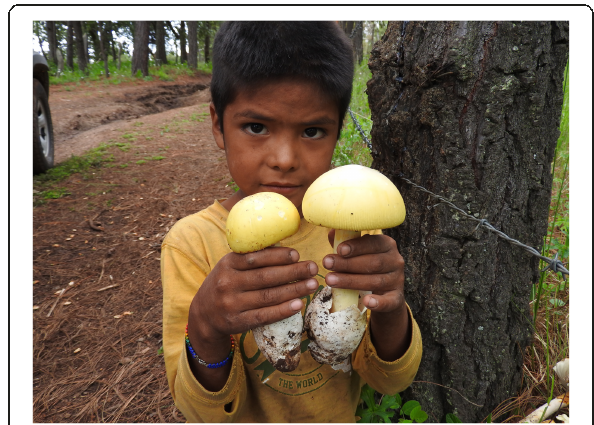
Fig. 6 Alex, Wixarika child showing Amanita